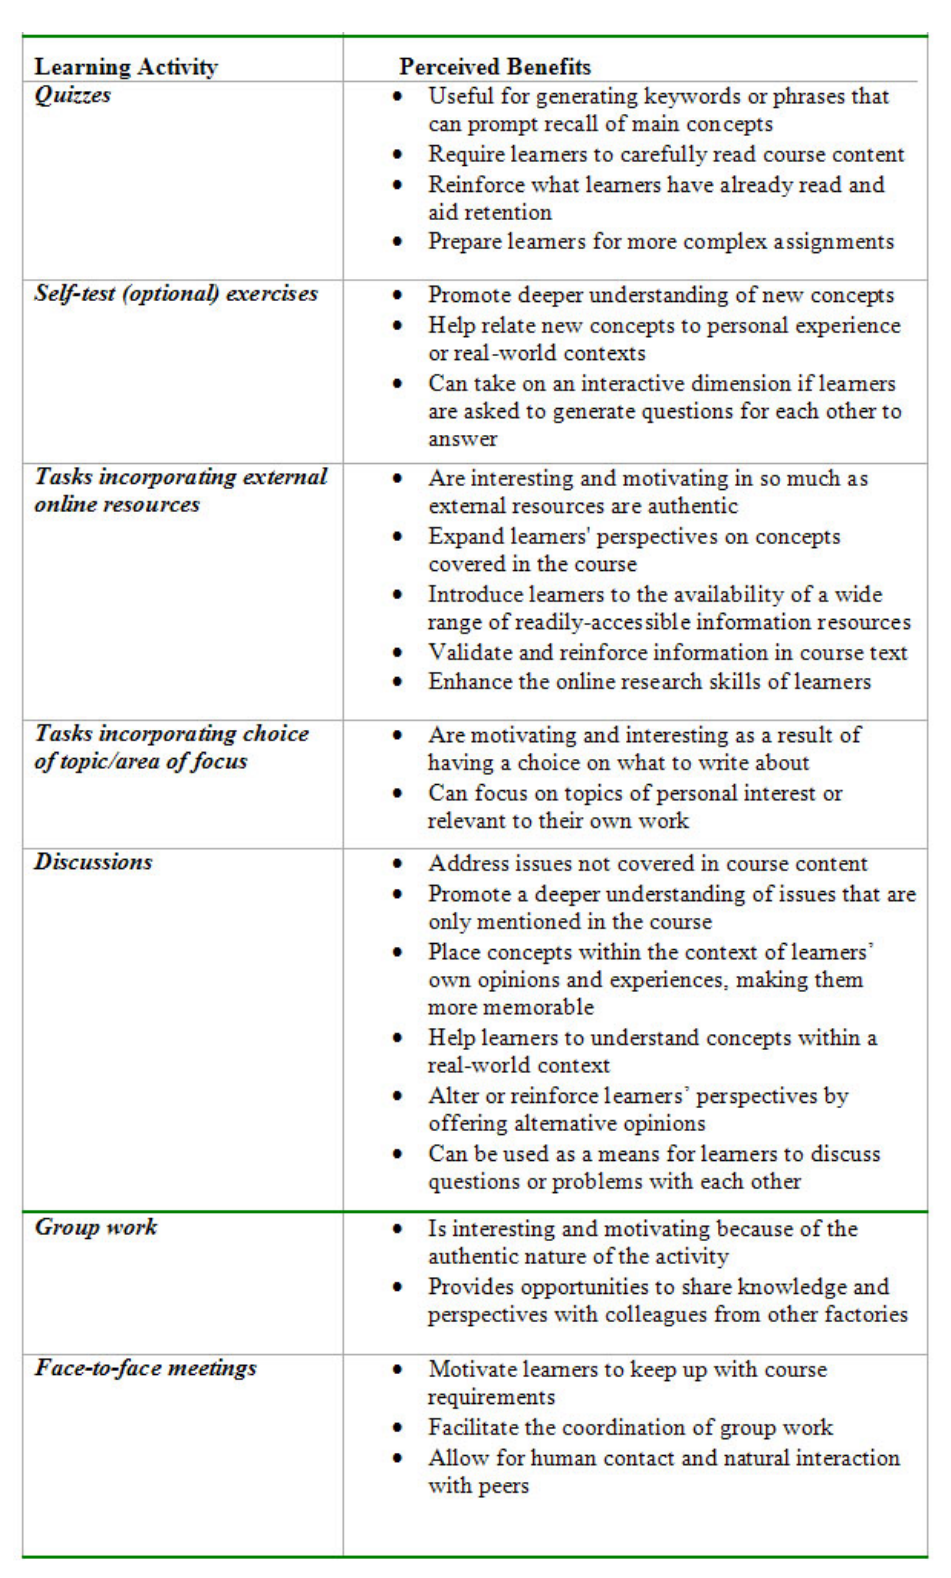
Table 2: Participants' Opinions on Perceived Benefits of Learning